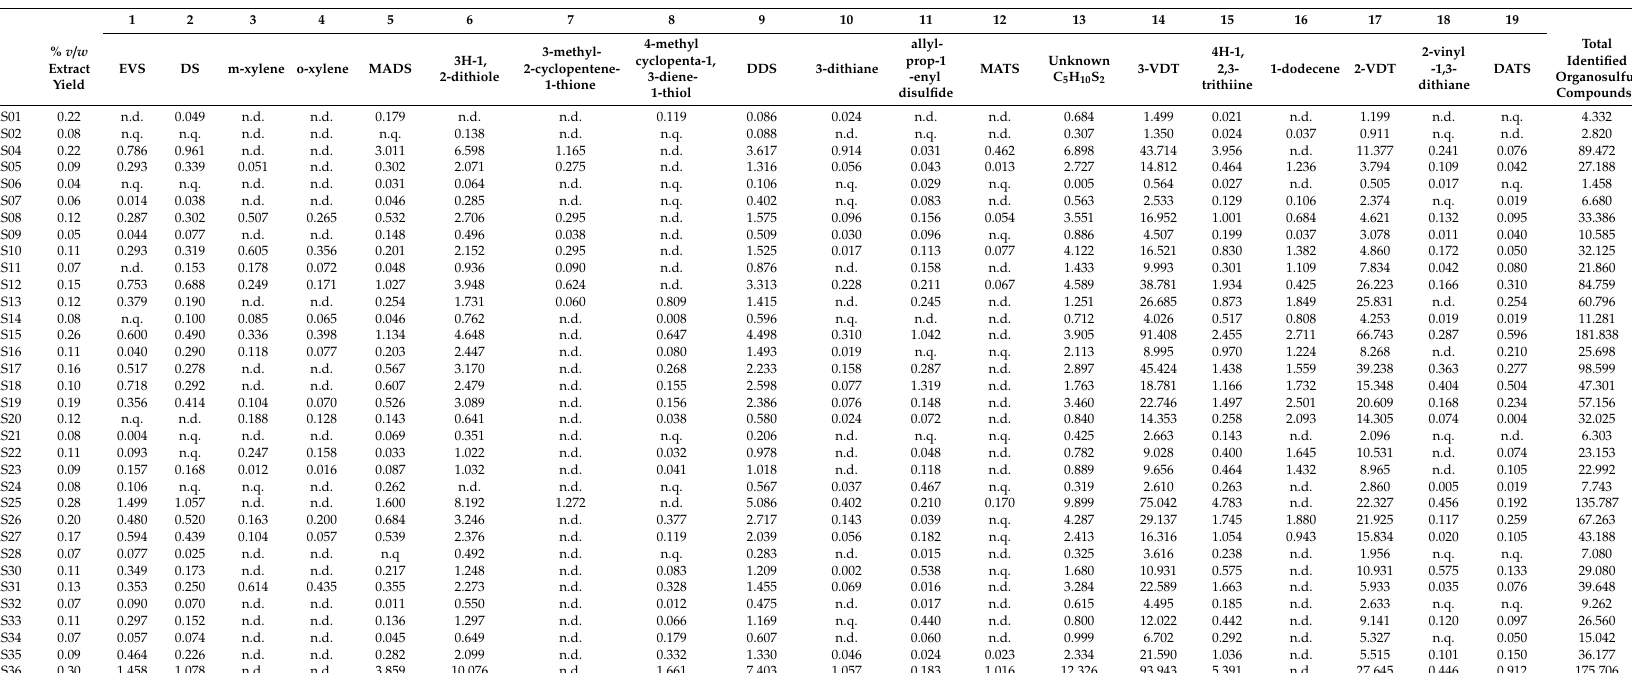
Table 2. Ethyl acetate extract yield (% v / w ) and mean concentration (mg per 100 g of fresh weight) of volatiles determined in the ethyl acetate extracts of the garlic genotypes 1